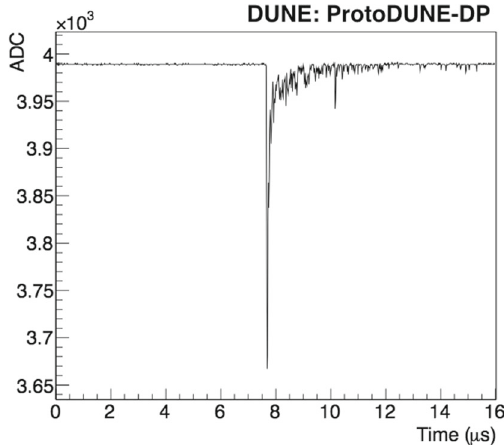
Fig. 6 Baseline mean STD during ProtoDUNE-DP operation. A fit to the mean value (0 . 6 ± 0 . 1ADC) is shown in red and error bars represent the differences among the different